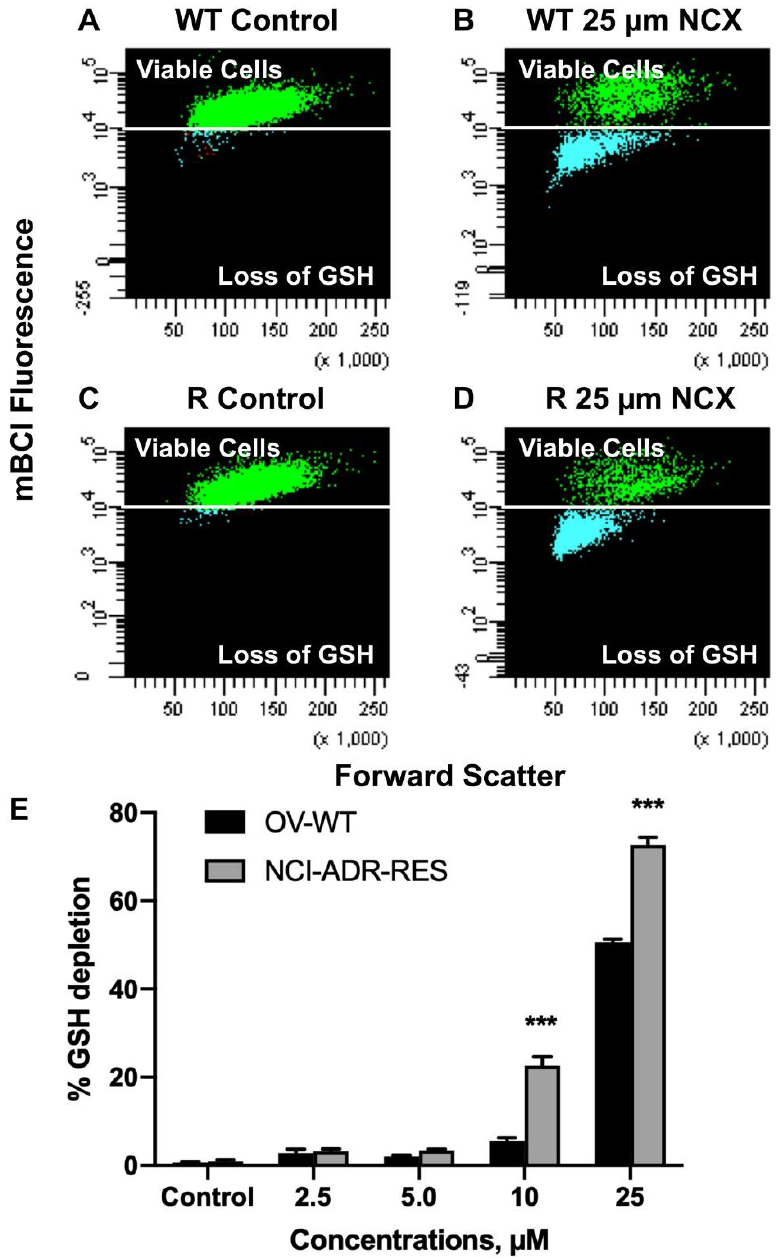
Figure 3. Percent GSH depletion in OVCAR-8 ( A , B ) and in NCI/ADR-RES cells ( C , D ) and concentration dependence of GSH depletion by NCX4040 for 4 h ( E ). Representative plots ( A – D ) are shown here. *** p -values, <0.001, compared to concentration-matched NCI/ADR-RES.